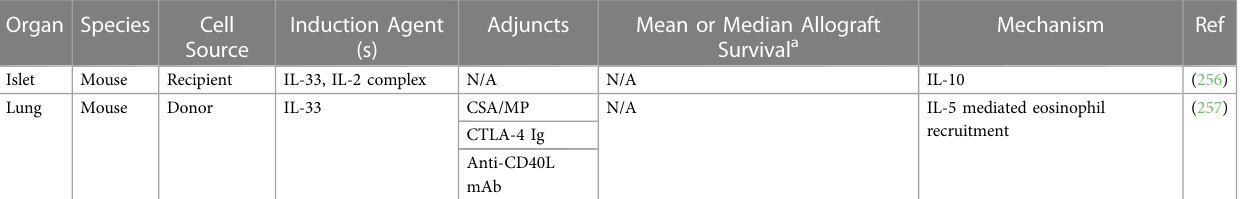
TABLE 5 Studies of ILC2s in animal models. Organ